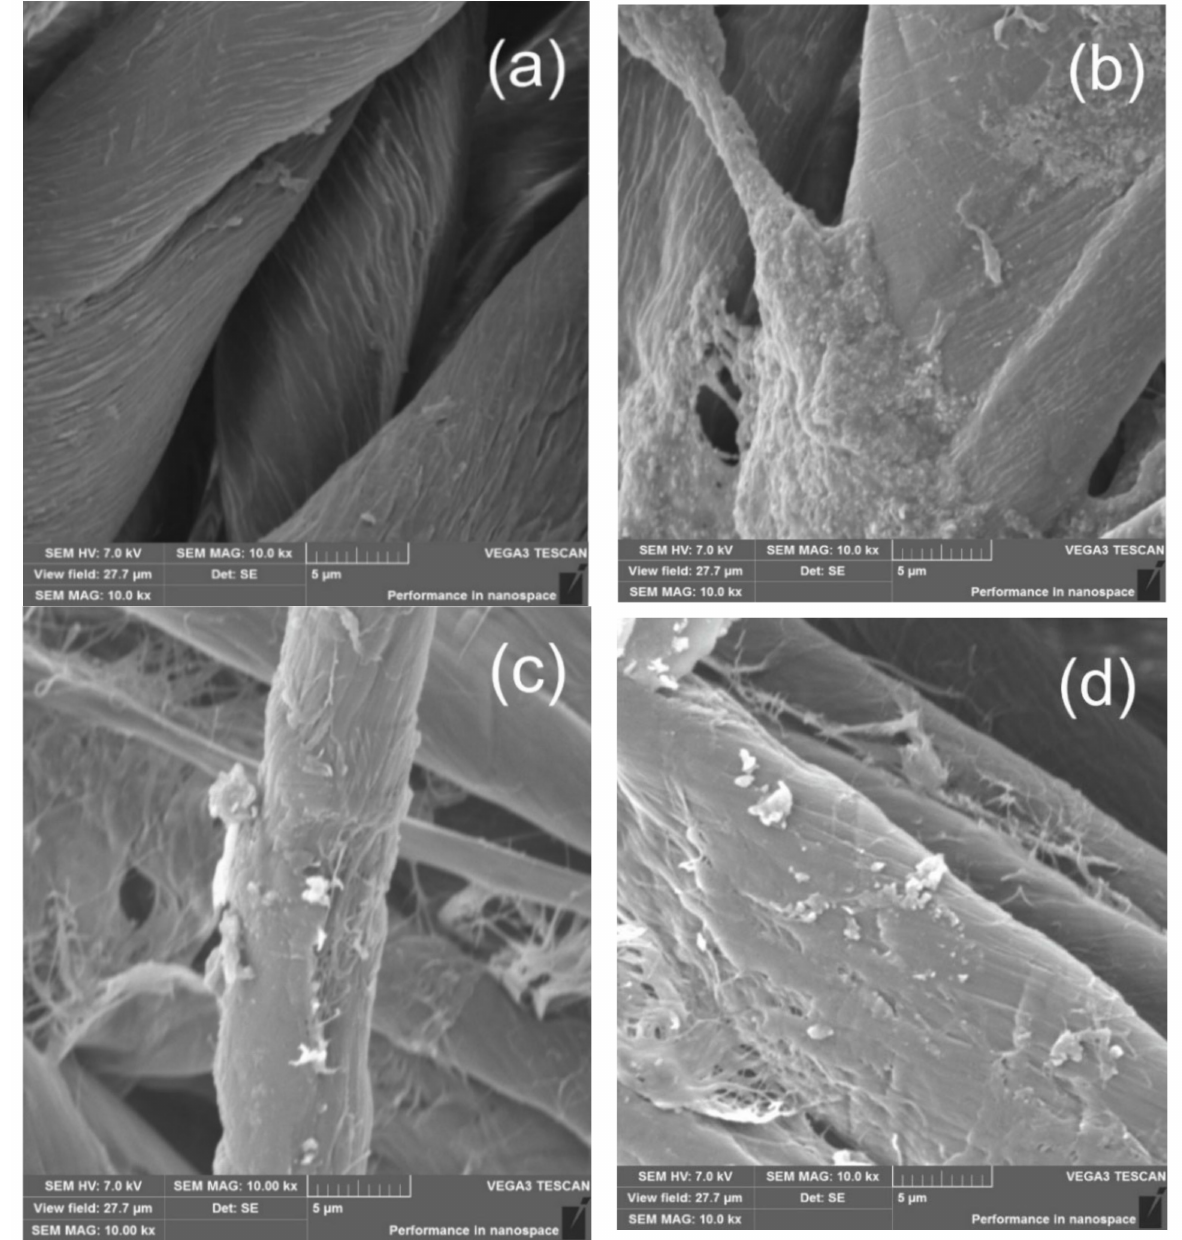
Figure 1. SEM images of ( a ) unmodified, ( b ) modified before washing, ( c ) modified after 15 washings, and ( d ) modified after 30 washings cotton terry